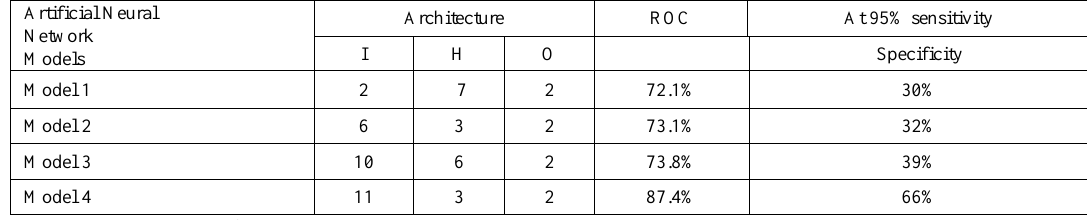
Table 5. Architecture of fitted ANN models and ROC AUC